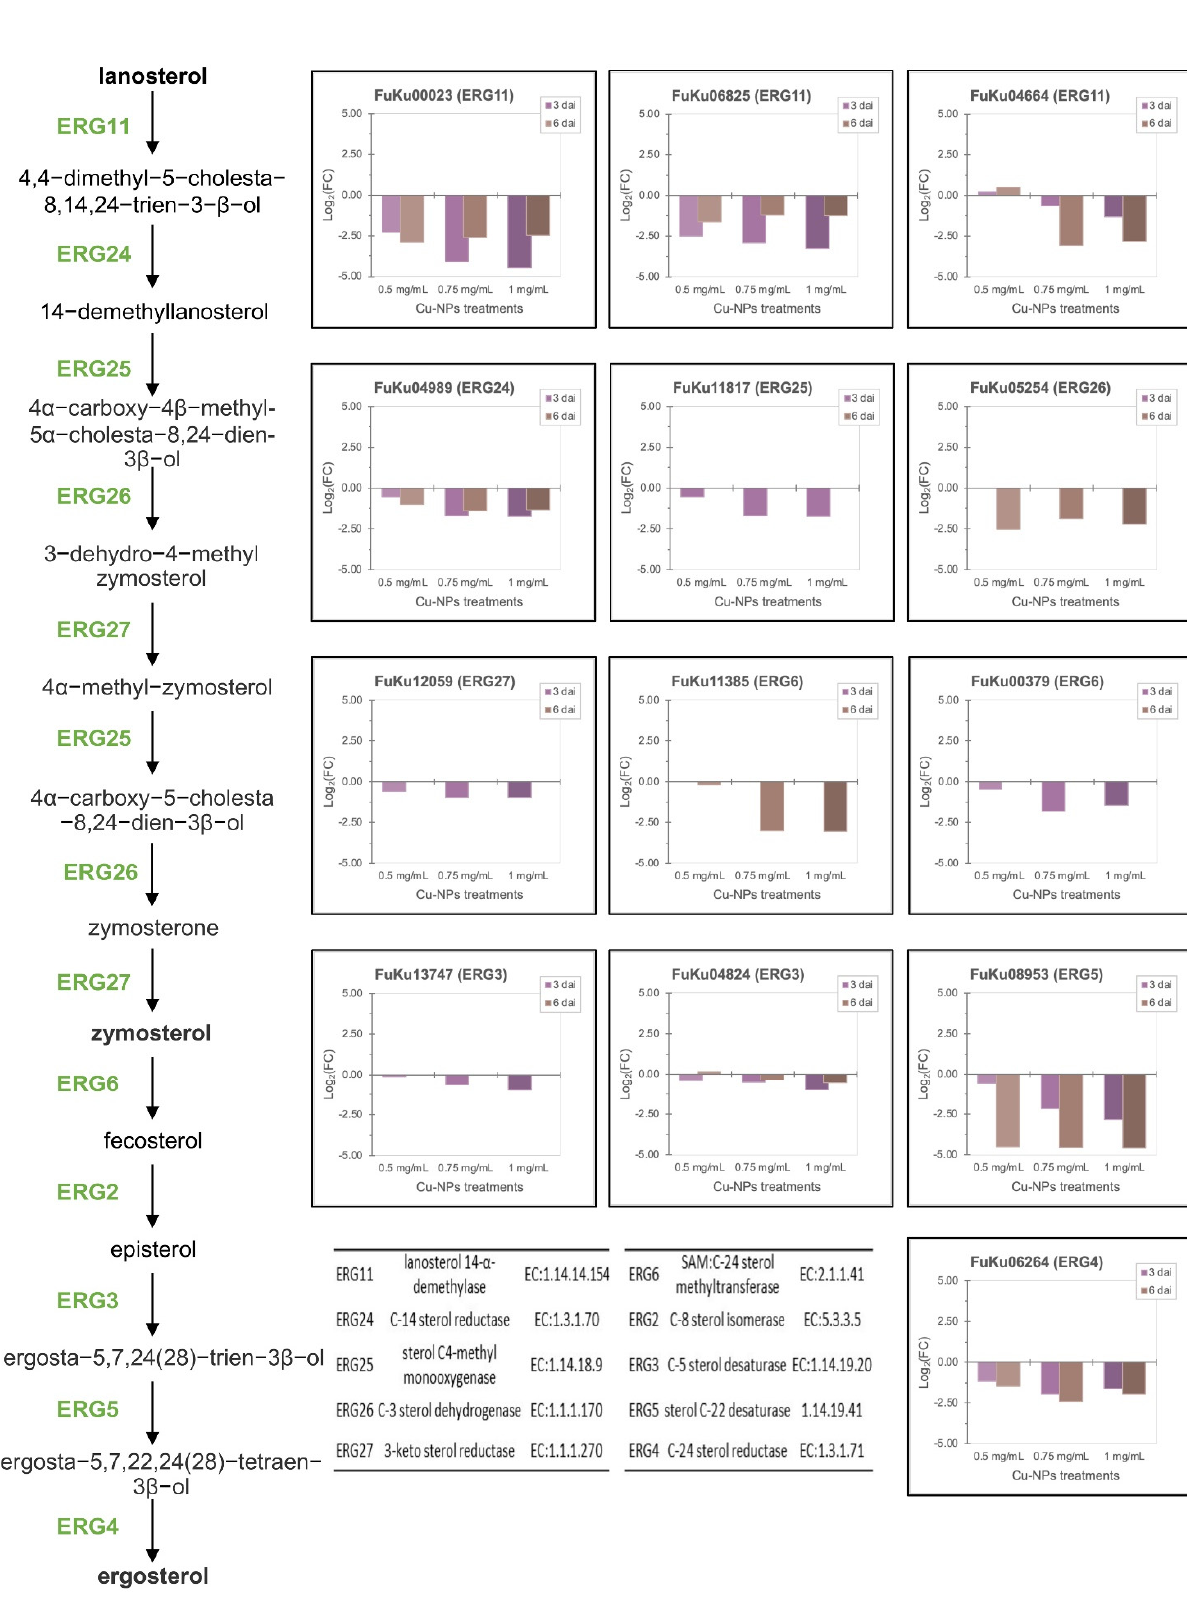
Figure 6. Ergosterol biosynthesis pathway (left) shows the expression profiles of F. kuroshium genes (ERG enzymes) involved. These expression profiles were significant in RNAseq differential expression analysis and are represented as Log 2 FC values. Enzyme names and corresponding Enzymatic Commission (EC) numbers are also shown.